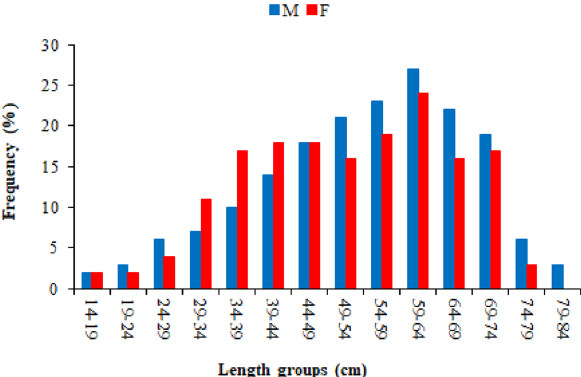
Figure 3. The length distribution of M. mastacembelus population inhabiting Keban Dam